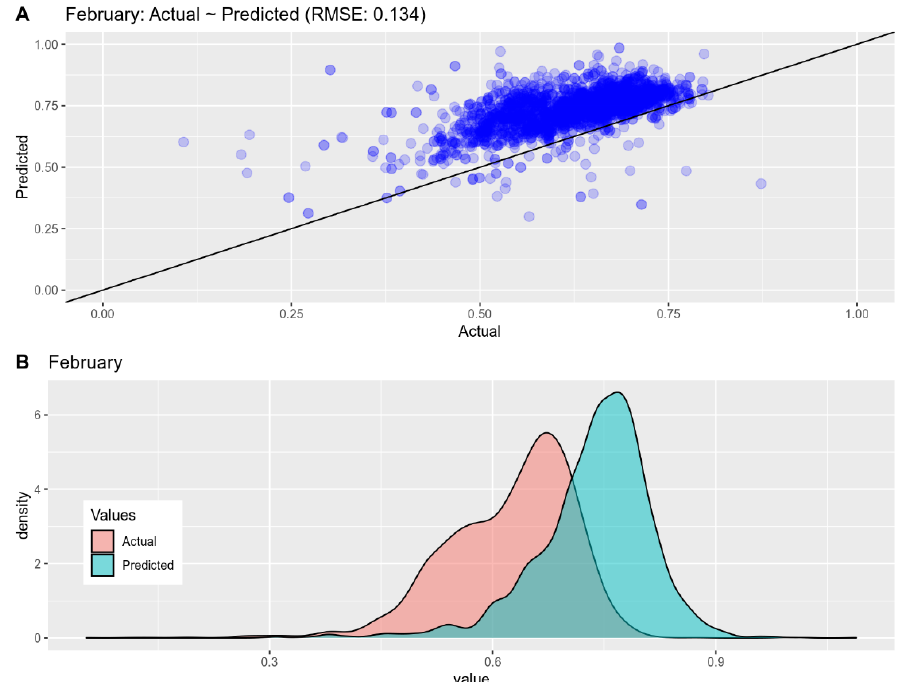
Figure A2. Comparison between actual~predicted for February 2020.